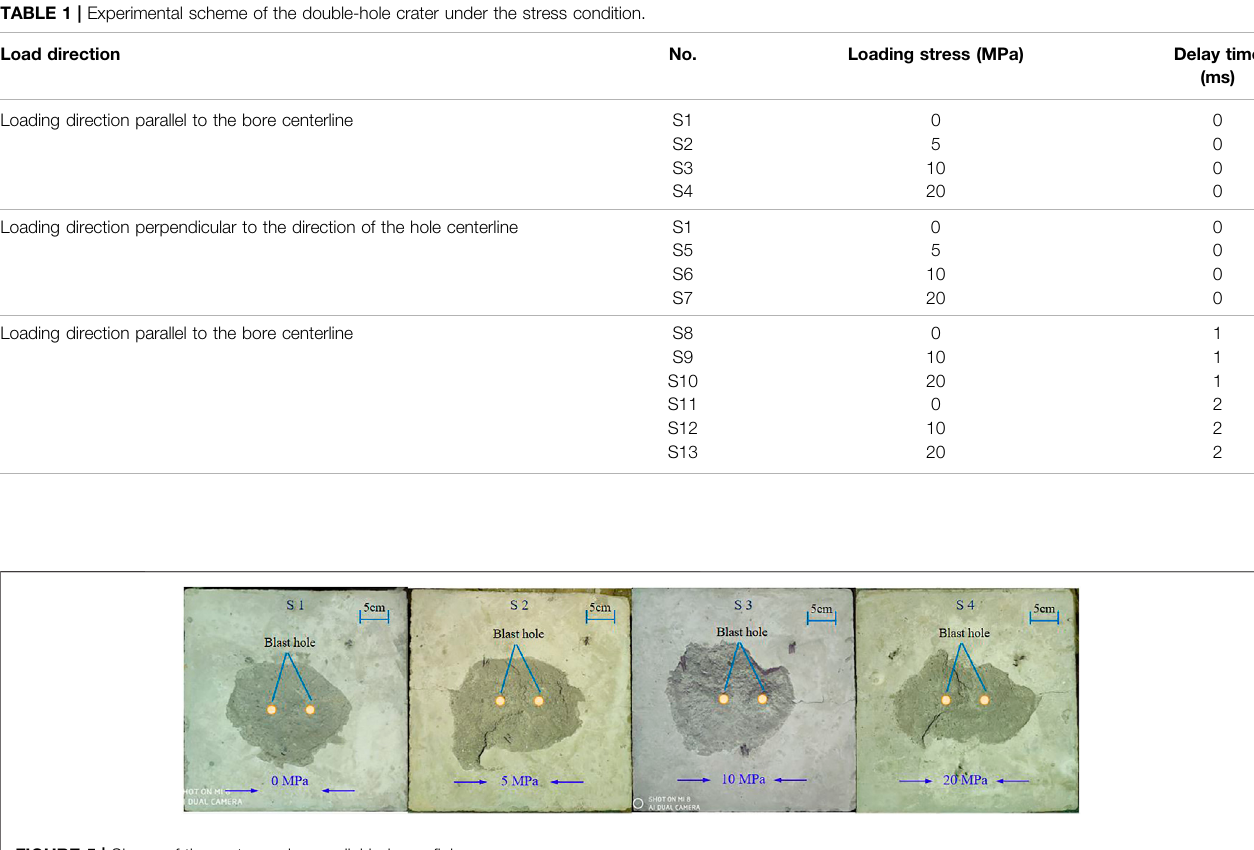
FIGURE 5 | Shape of the crater under parallel hole con fi ning